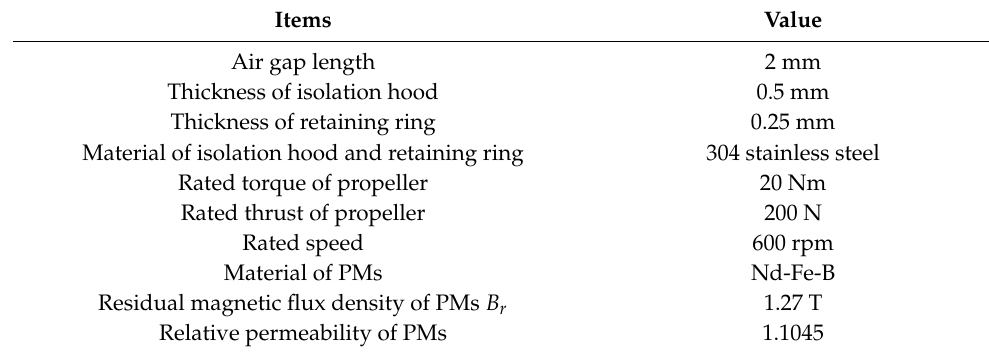
Table 5. Sizing constraints and performance requirements of the C-HPMC for underwater propulsion.